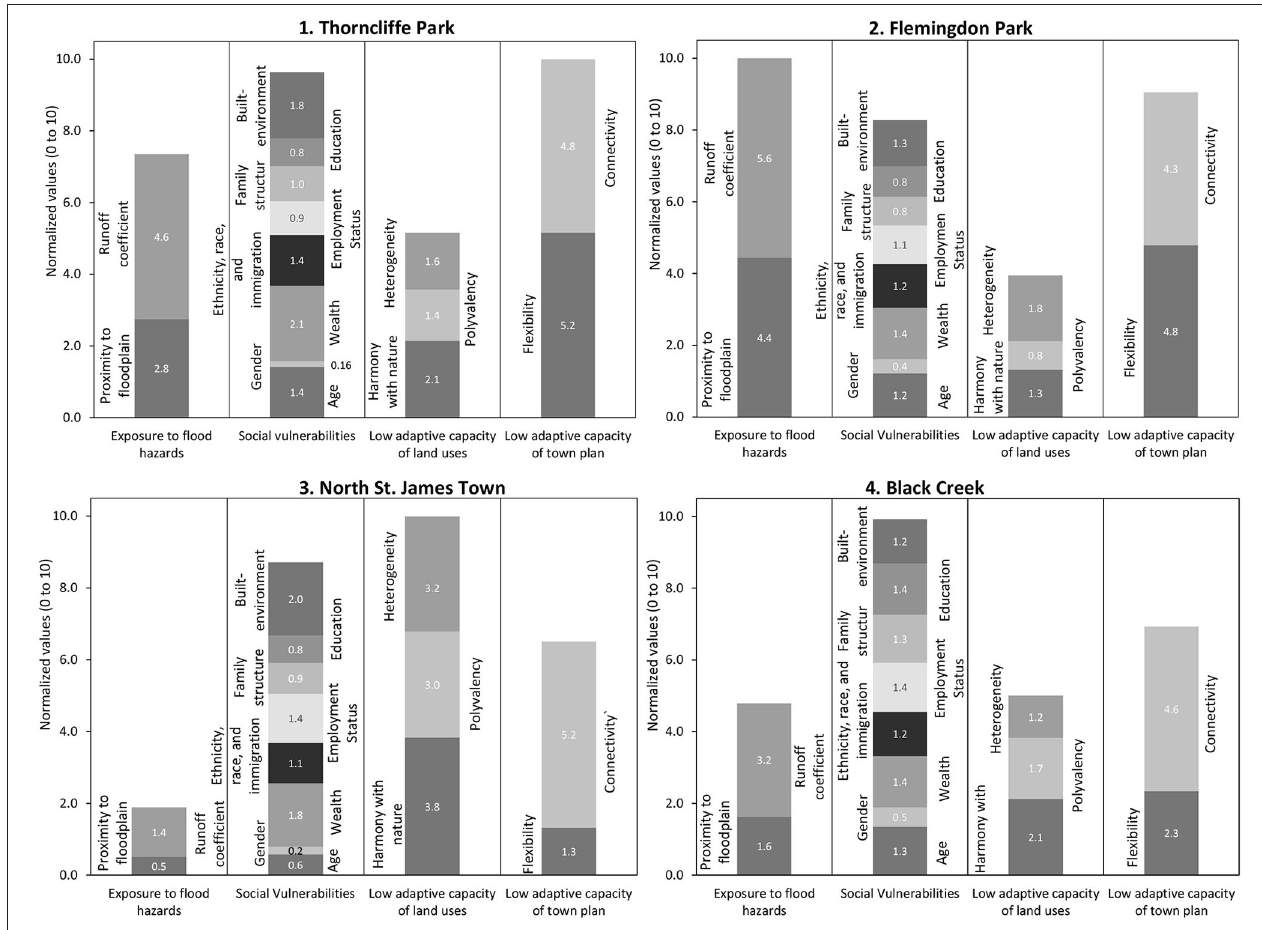
FIGURE 8 | The values of risk drivers and their indicators in the three priority